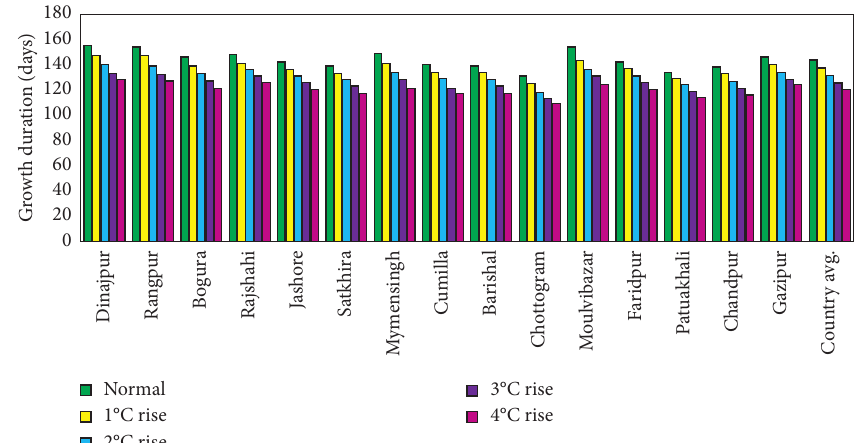
Figure 4: Spatial distribution of growth duration of BRRI dhan28 with different temperature rising scenarios.